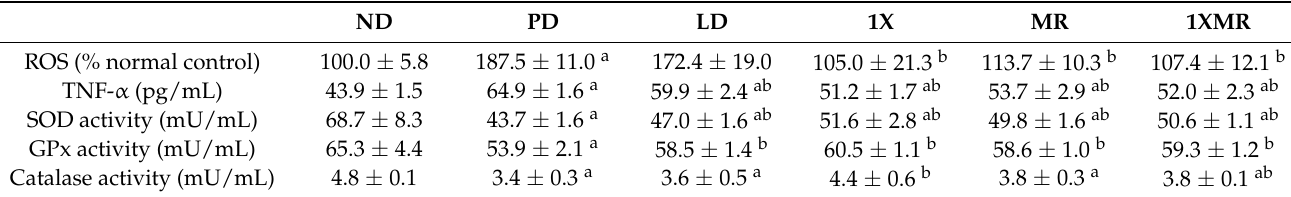
Table 1. Effects of 8 weeks’ supplementation with 1X, MR, and 1XMR on the serum levels of ROS and TNF- α and activity of antioxidant